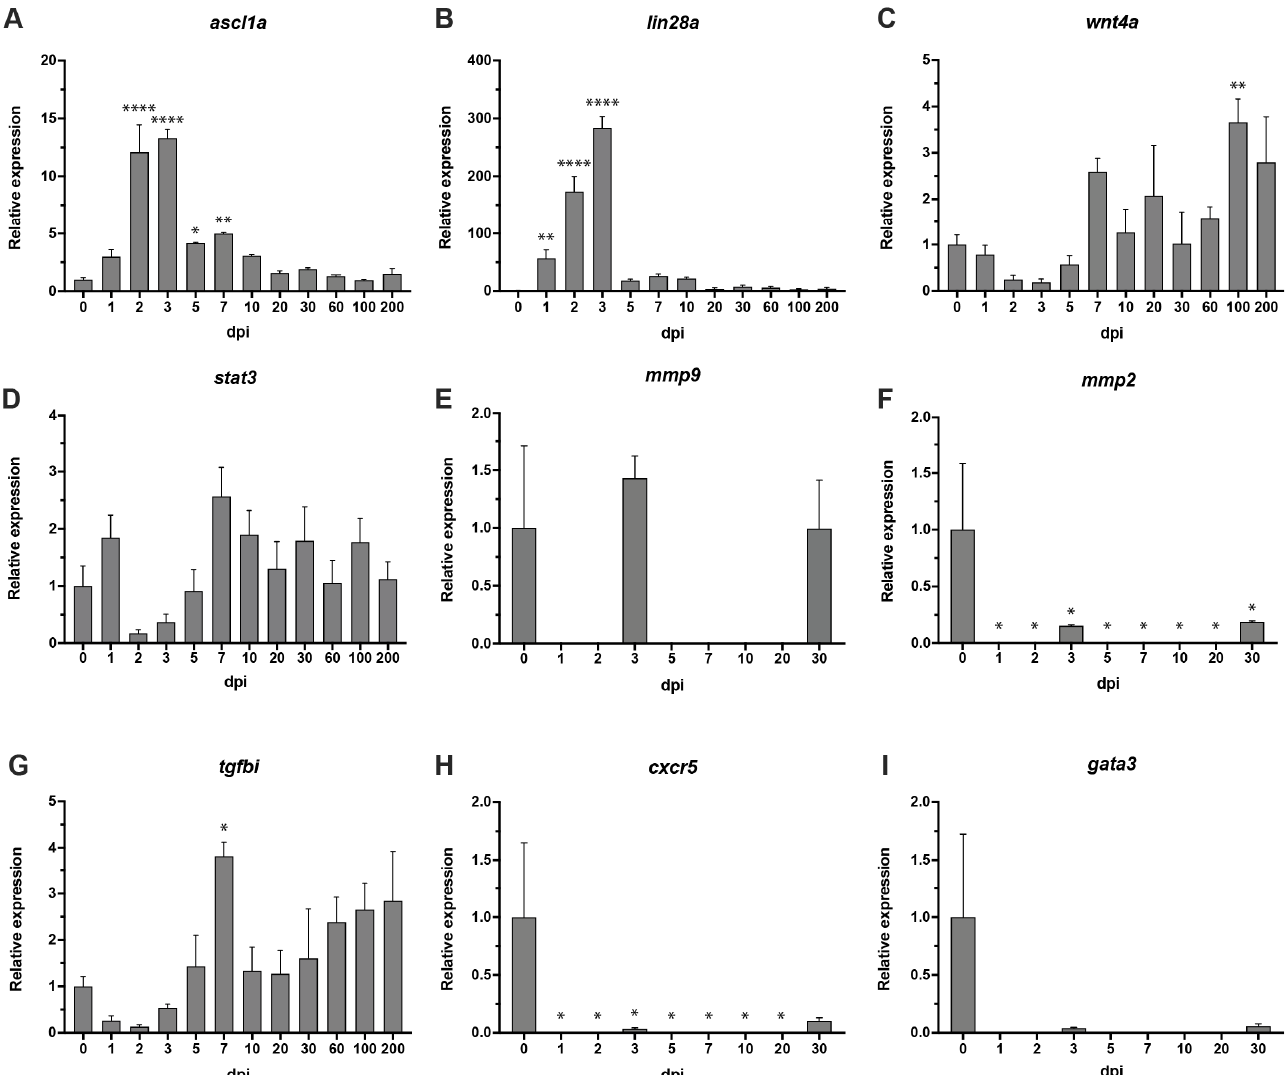
Figure 6. RT-PCR: ( A ) ascl1a was significantly expressed in the early stages of regeneration beginning at 2 dpi through to 7 dpi. ( B ) Significant expression of lin28a from 1 to 7 dpi. ( C ) wnt4a showed significant upregulation at 100 dpi. ( D ) stat3 showed no differential expression throughout any of the time points, 1–200 dpi. ( E , F ) mmp9 showed no changes in expression, mmp2 was downregulated throughout all time points. No expression was detected at time points 1 dpi, 2 dpi, 5 dpi, 7 dpi, 10 dpi and 20 dpi for both, mmp9 and mmp2 . ( G ) tgfbi showed significant change in expression at 7 dpi. ( H ) cxcr5 showed differential expression at 1–30 dpi. No expression was detected at time points 1 dpi, 2 dpi, 5 dpi, 7 dpi, 10 dpi and 20 dpi. ( I ) gata3 reported no significant differential expression at any of the time points. No expression was detected at time points 1 dpi, 2 dpi, 5 dpi, 7 dpi, 10 dpi and 20 dpi. Uninjured retina—0 dpi. β -actin served as reference gene. Three independent replicates were carried out for each gene at each time point. Error bars represent +/ − standard error of the mean (SEM). Stars used to denote significance * p value < 0.01, ** p value < 0.005, **** p value < 0.0001. There was no differential expression noted for stat3 for any of the time points, con- trary to previous report showing expression of stat3 as early as 5 to 36 h of constant light